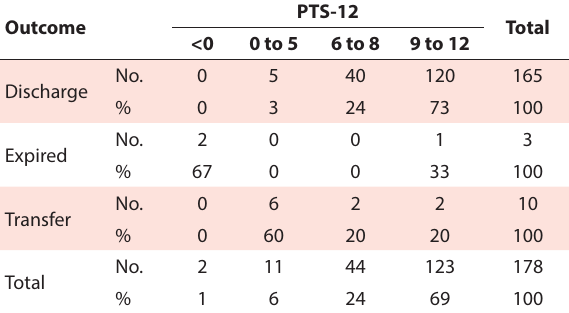
Table 3. Distribution of Outcome with PTS Outcome